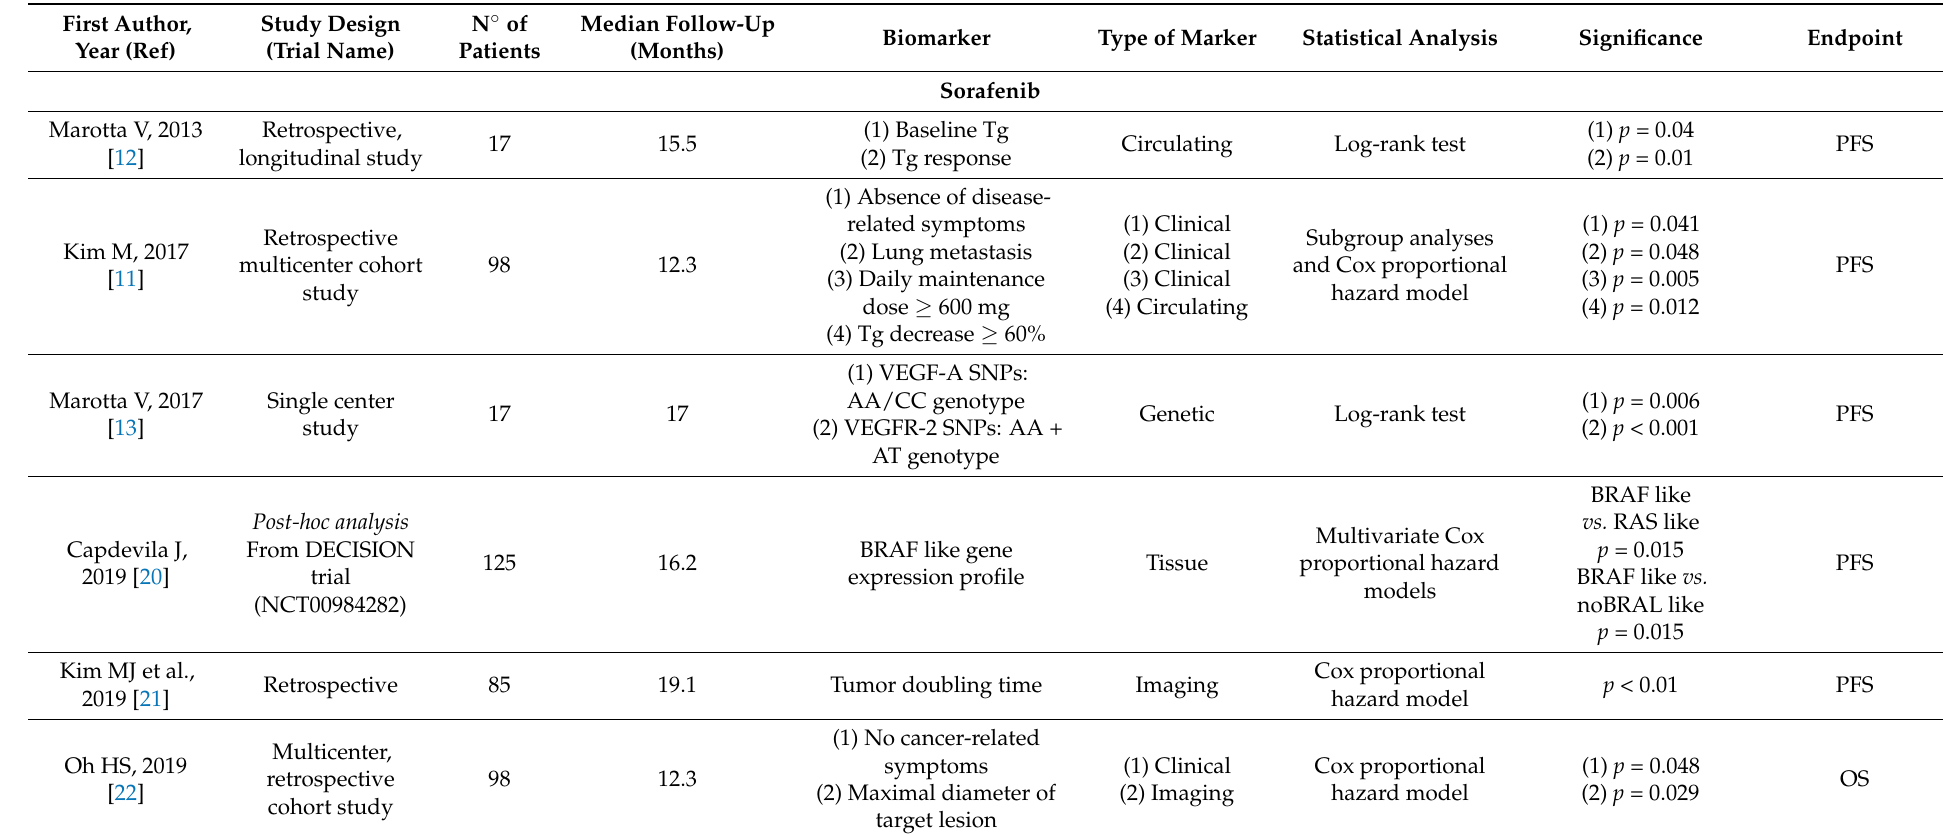
Table 2. Predictive markers of survival in progressive RAI-refractory DTC treated with sorafenib or Lenvatinib. DSS, disease specific survival; OS, overall survival; PFS, progression free